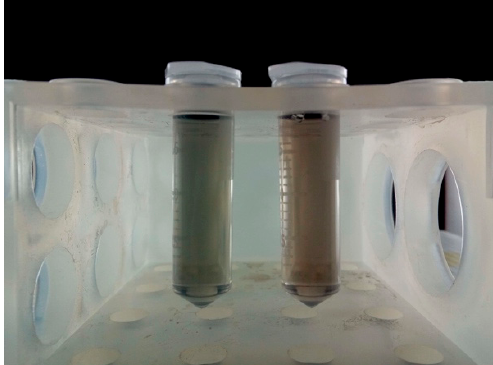
Figure 5. Photograph of the two phases after separation into CNT dispersions, composed predominantly of metallic (left) and semiconducting (right) species.